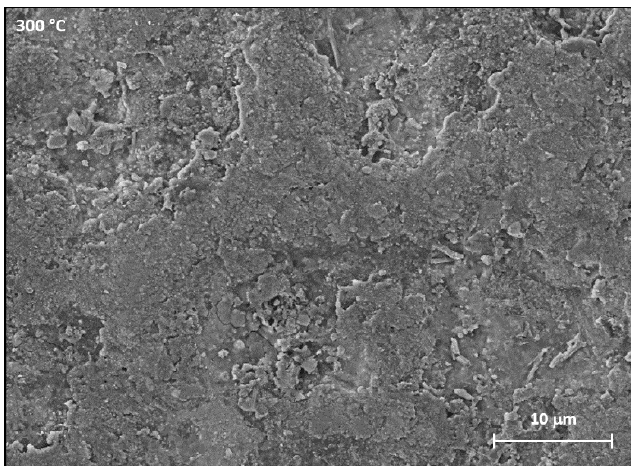
Figure 6. Highlight of the samples heated at 300 °C.